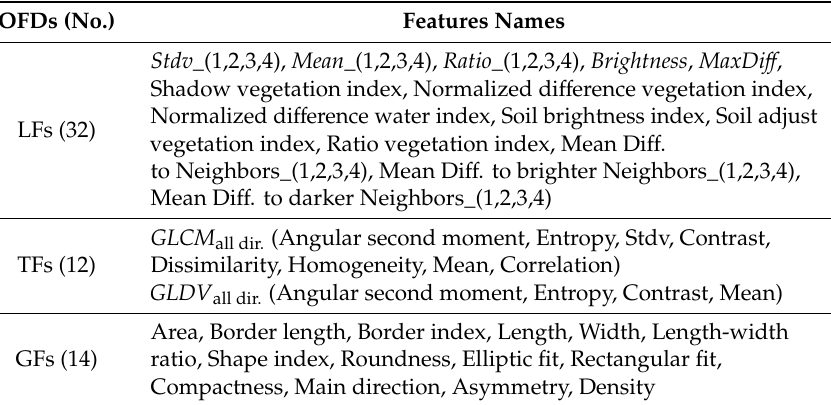
Table 1. Object features employed in this research. OFDs: object-feature domains; LFs: layer features; TFs: texture features; GFs: geometry features. OFDs (No.) Features Names Shadow vegetation index, Normalized di ff erence vegetation